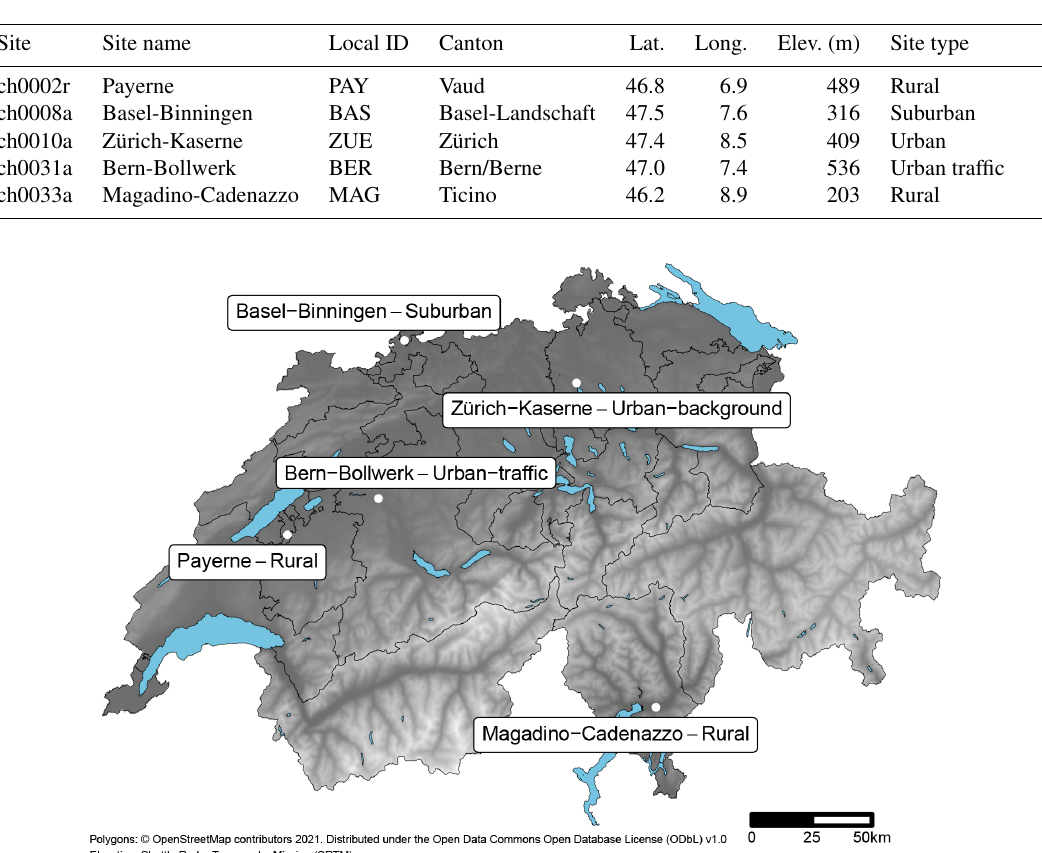
Table 1. Basic information for the five monitoring sites in Switzerland that were used for PM oxidative potential measurements.